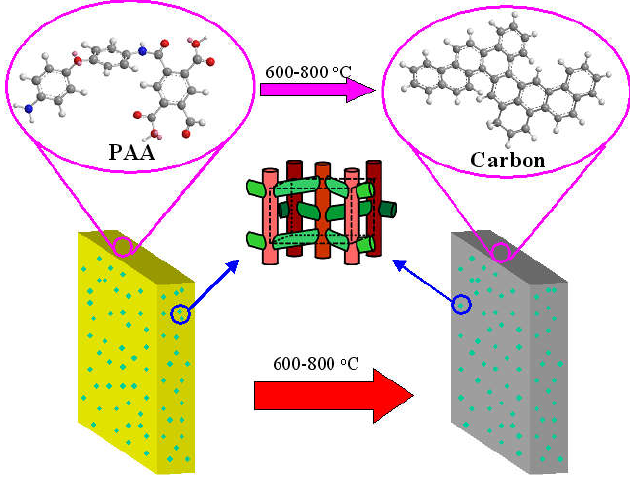
Figure 9. The structure model of zeolite/C hybrid membrane (e.g., ZSM-5/C hybrid membrane) [56].